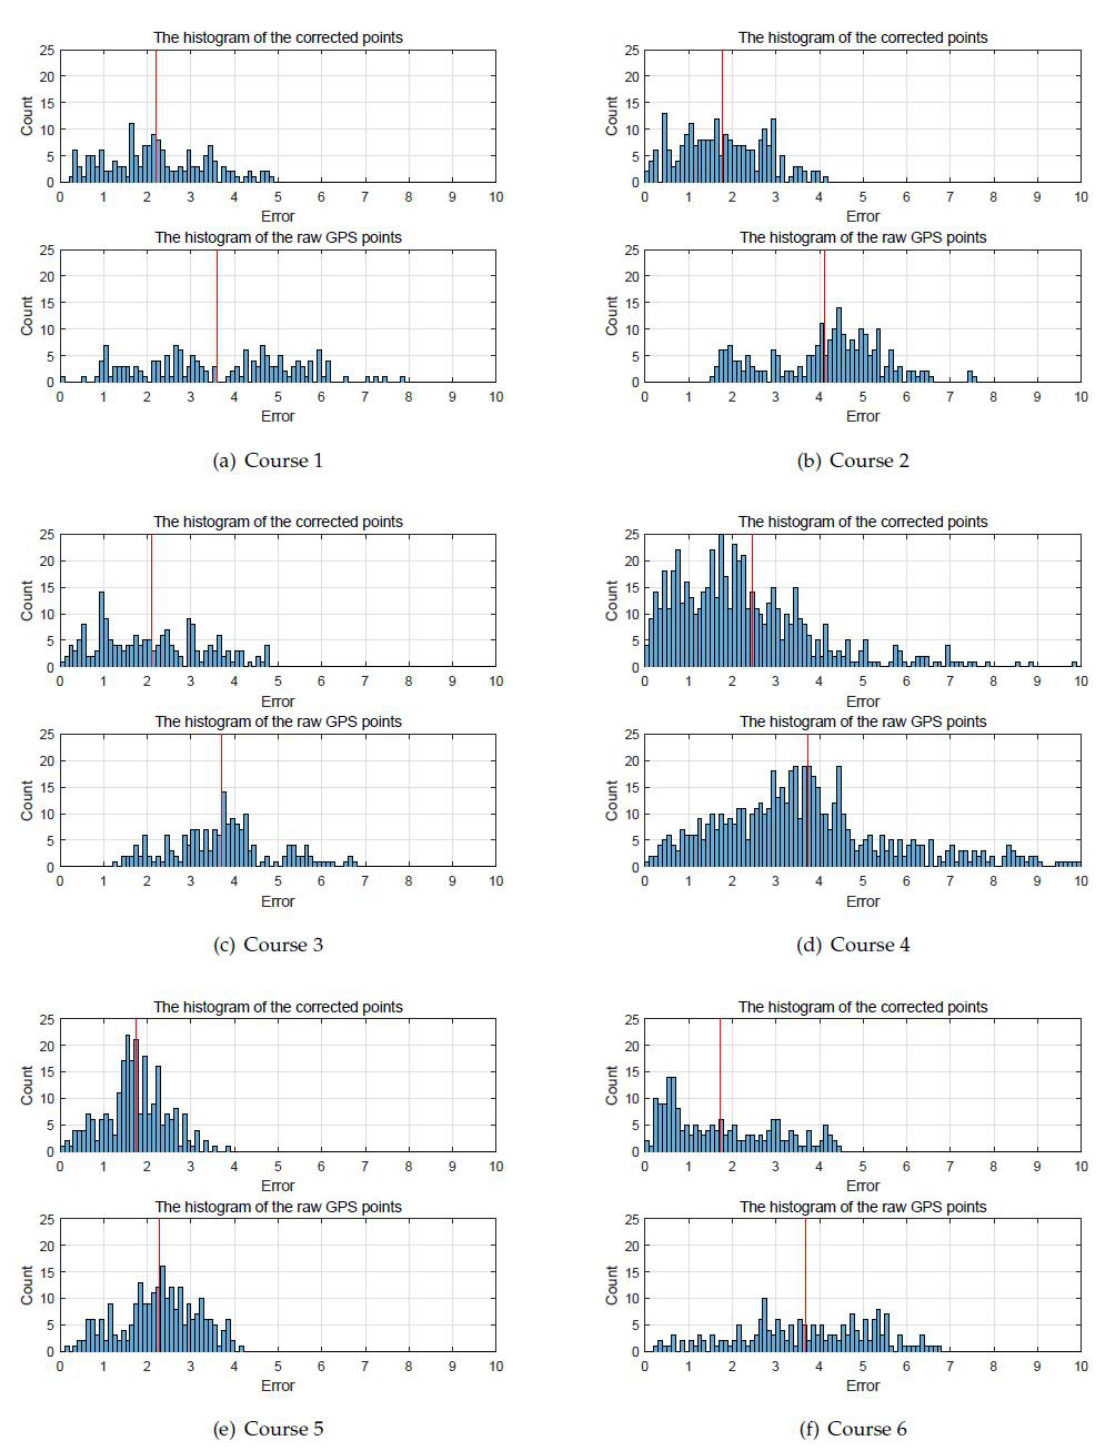
Figure 14. Error histograms. The blue bars represent the error distributions, while the red line marks the average value of each error